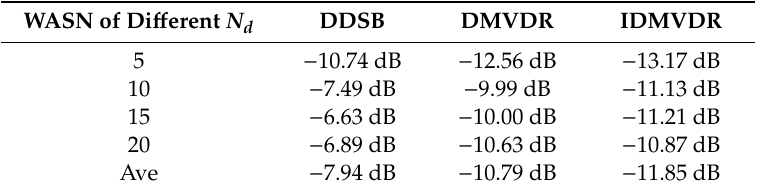
Table 5. The noise reduction performance of di ff erent N d in terms of MSE.